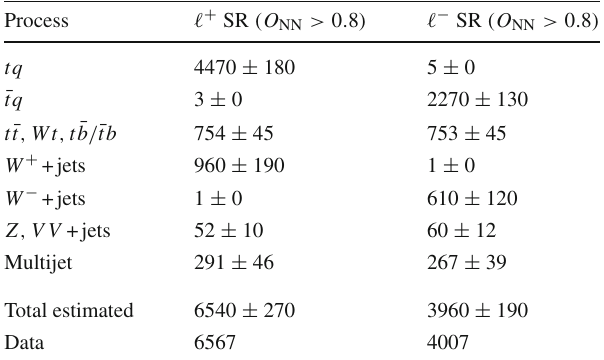
Table 7 Predicted (post-fit) and observed event yields for the signal region (SR), after the requirement on the neural network discriminant, O NN > 0 . 8. The multijet background prediction is obtained from the fit to the E miss distribution described in Sect. 6, while all the other T predictions and uncertainties are derived from the total cross-section measurement. An uncertainty of 0 means that the value is < 0 . 5